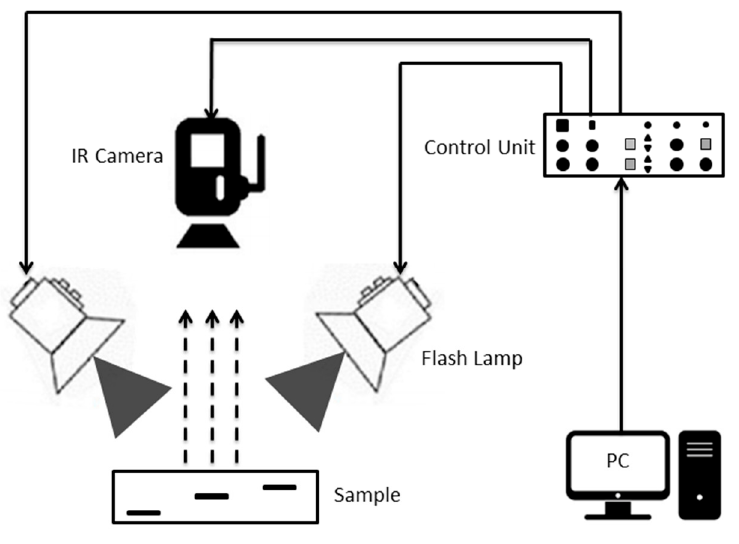
Figure 2. Experimental configuration of a pulsed thermography inspection system.